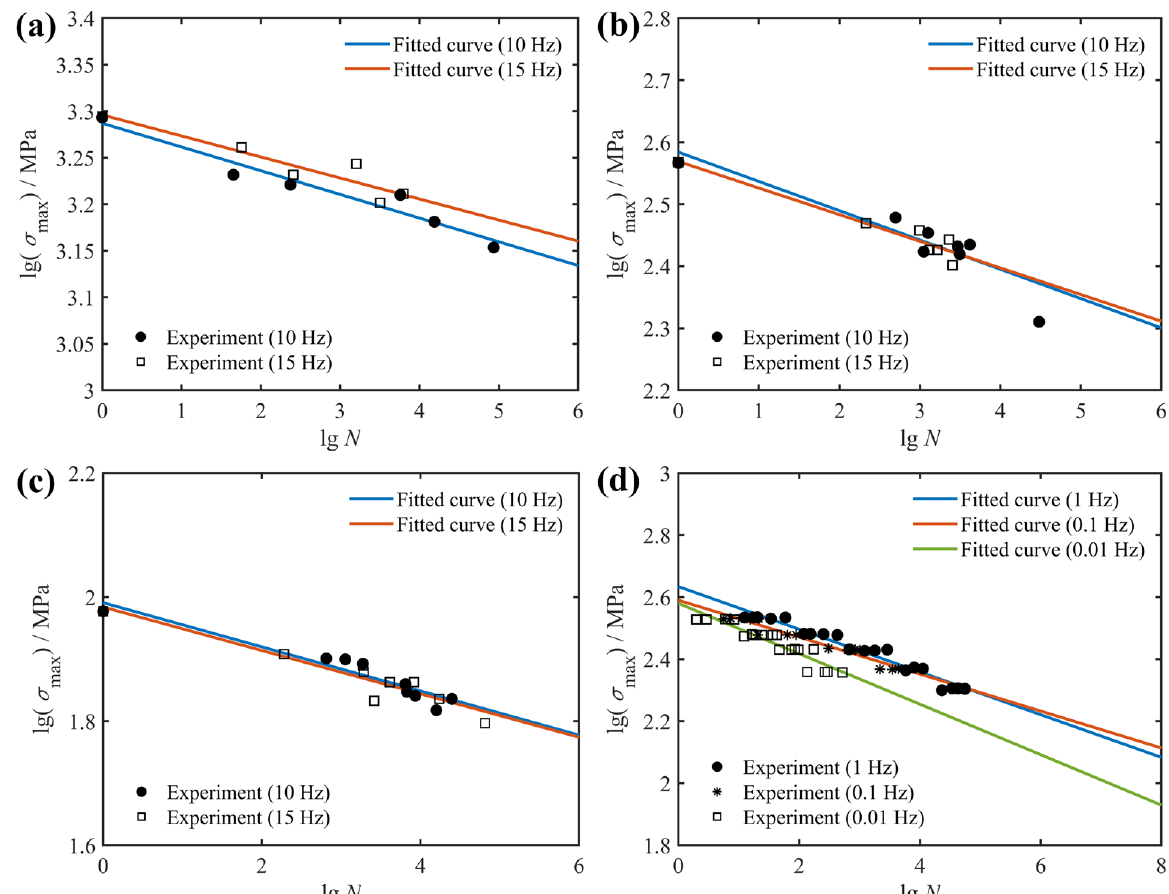
Figure 3. Effect of loading frequency on fatigue life of: ( a ) graphite/epoxy [0°] 4 ; ( b ) graphite/epoxy [15°] 4 ; ( c ) graphite/epoxy [45°] 4 ; ( d ) E-glass/epoxy [0°/90°] S , together with experimental data from Ref. [35] ( a – c ) and Ref. [31].